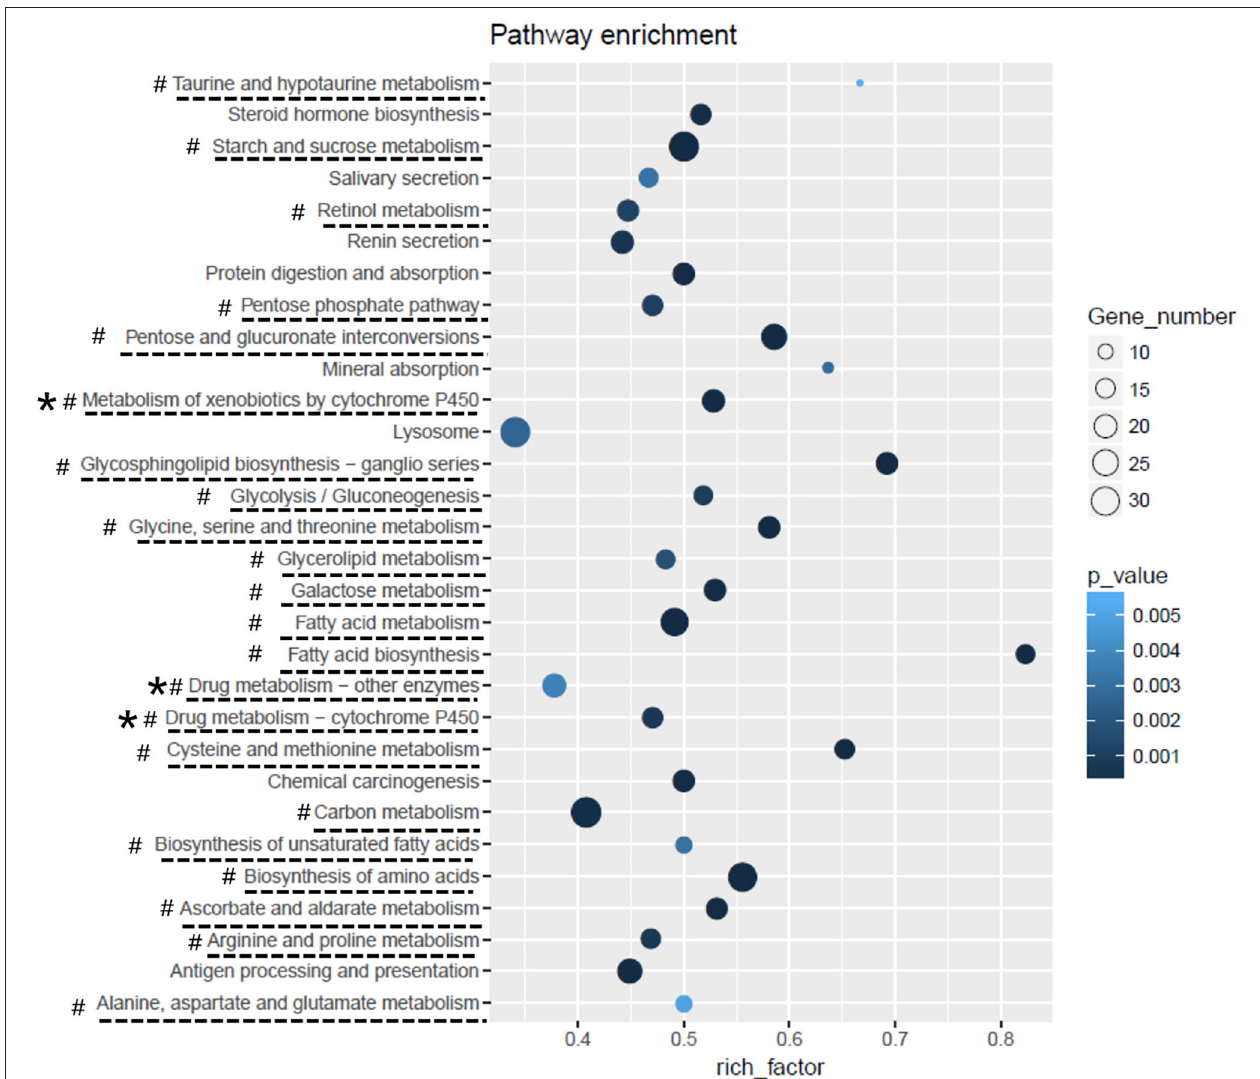
FIGURE 3 | The top-30 pathways of DEGs KEGG enrichment analysis. The pathways list from the bottom to the top were in order of the first letter of the pathway name, from A to Z. Rich_facotor means (number of DEG enriched in the pathway/number of background genes).